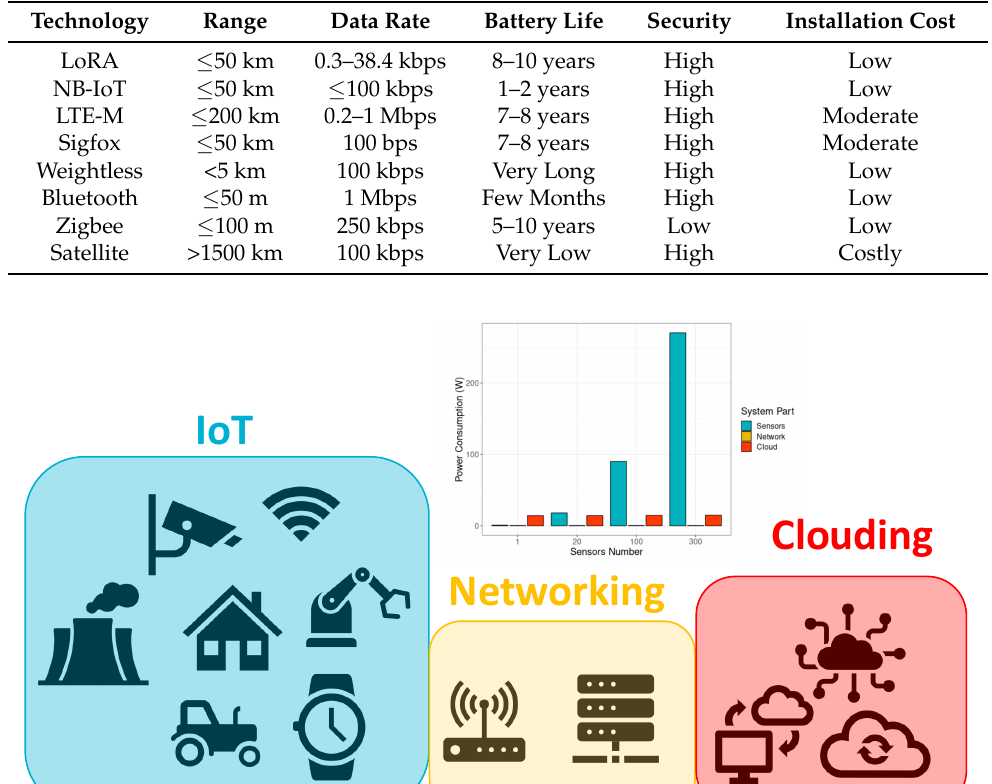
Table 1. Communication technologies for IoT devices.